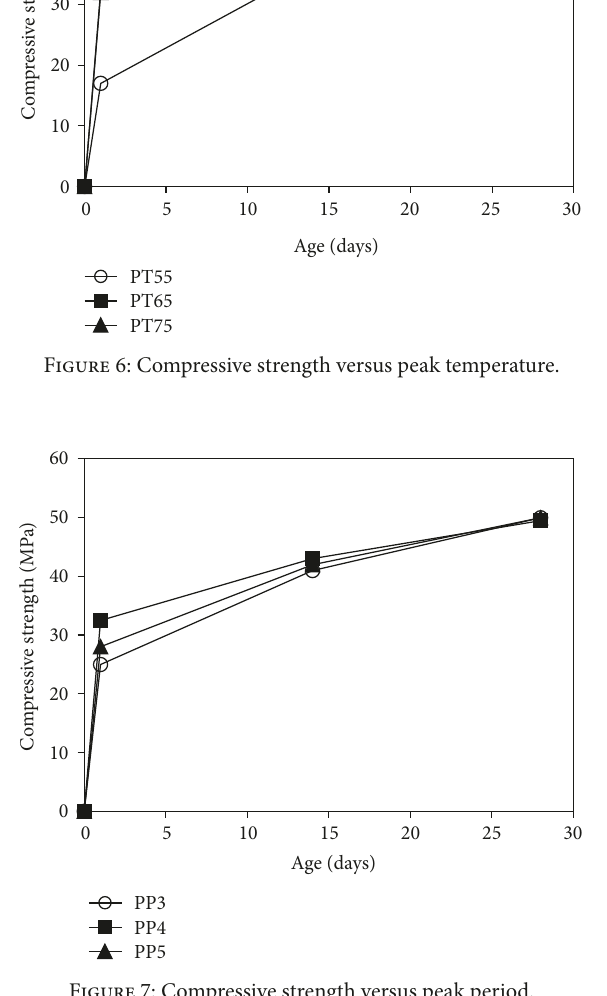
Figure 7: Compressive strength versus peak period.